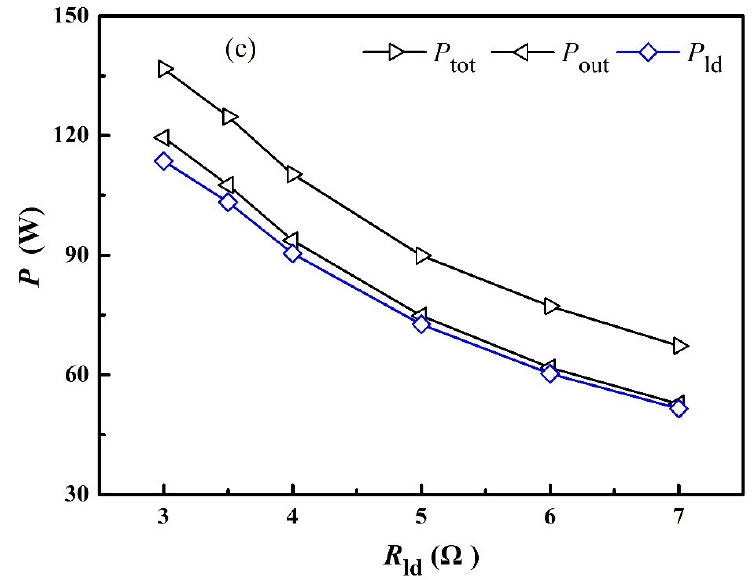
Figure 5. Power load feature when the output voltage is maintained at 19 V. ( a ) Input voltage and temperature. ( b ) Output voltage, load current, and load power. ( c ) Total power, output power, and load power.